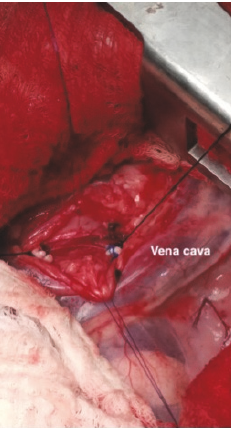
Figure 4: Posttransection of the right aortic arch with stay sutures in place. Note the vessel ends sutured with Prolene. The dog’s head is to the